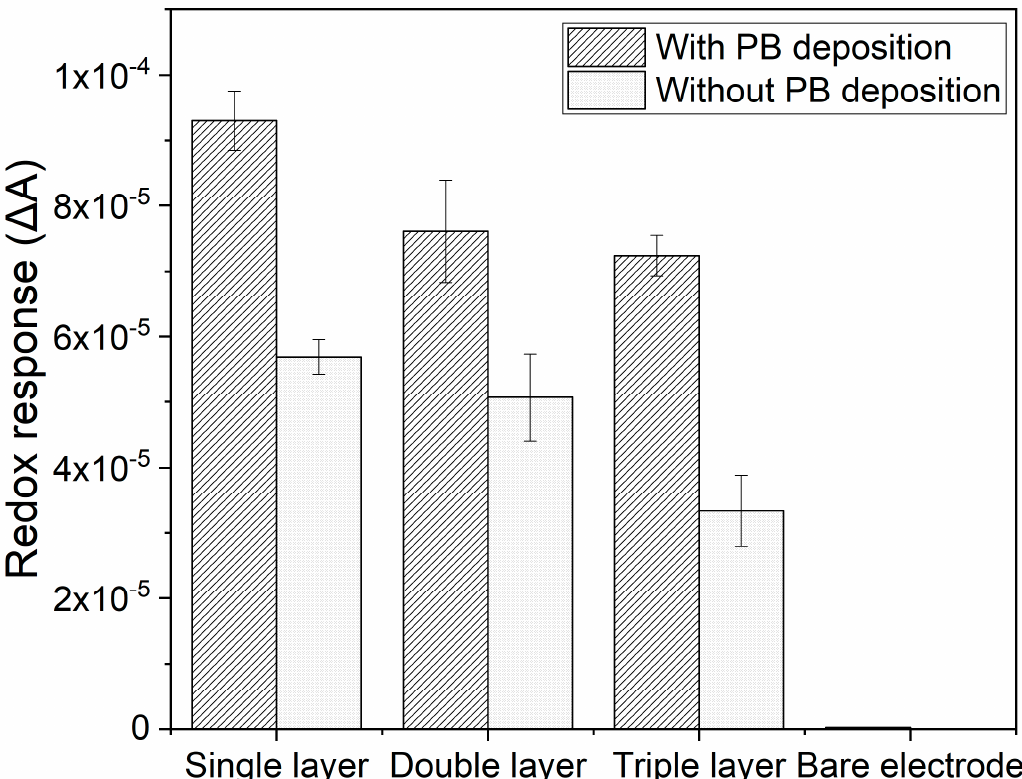
Figure 8. Redox responses ( ∆ A ) of the single, double, and triple layers of composite-modified electrodes with and without the PB deposition with 10 mM of •OH.